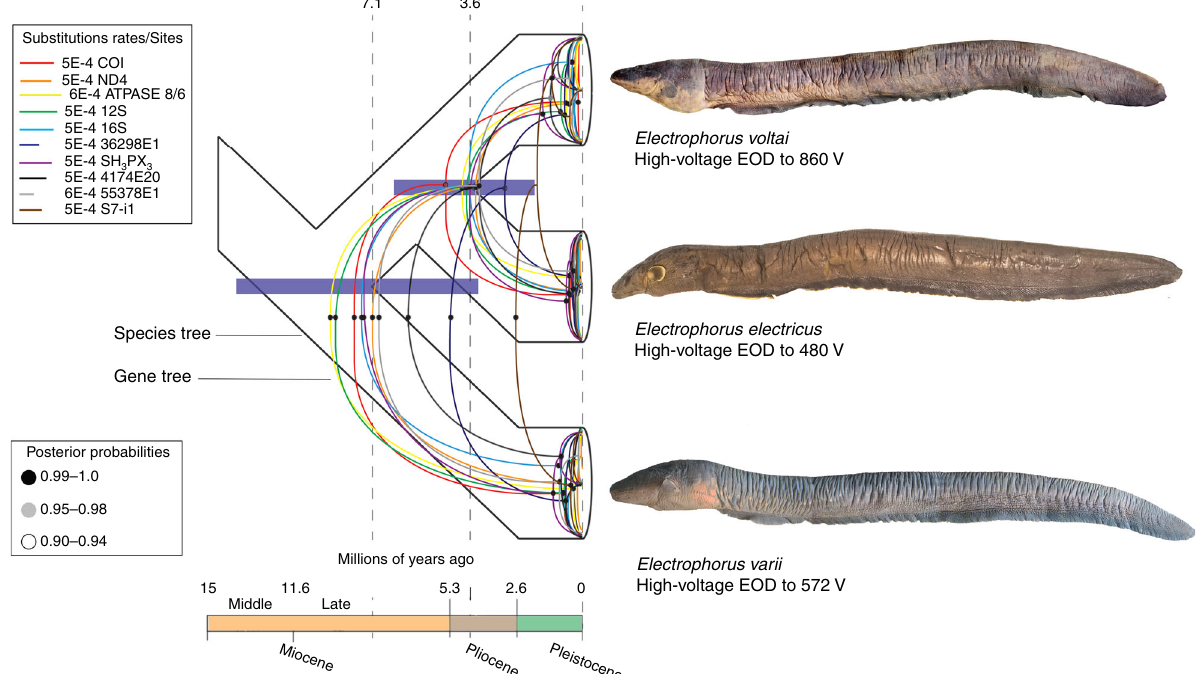
Fig. 3 Electrophorus tree of life and time of species diversi fi cation. Time-calibrated genealogy of Electrophorus based on a maximum clade credibility (MCC) species tree derived from *BEAST2.4 analyses of 10 genes (colored lines) and 94 specimens of Electrophorus (relaxed molecular clock and uncorrelated lognormal model implemented). Purple bars represent 95% highest posterior density distributions for the estimated divergence time of each major node. Voltage measurements made by us are reported below E . electricus (National Museum of Natural History, NMNH 225670, 520 mm TL, Corantijn River, Suriname), E . voltai (Museu Paraense Emílio Goeldi, MPEG 15529; holotype, 1290 mm TL), and E . varii (MPEG 25422; holotype, 1000 mm